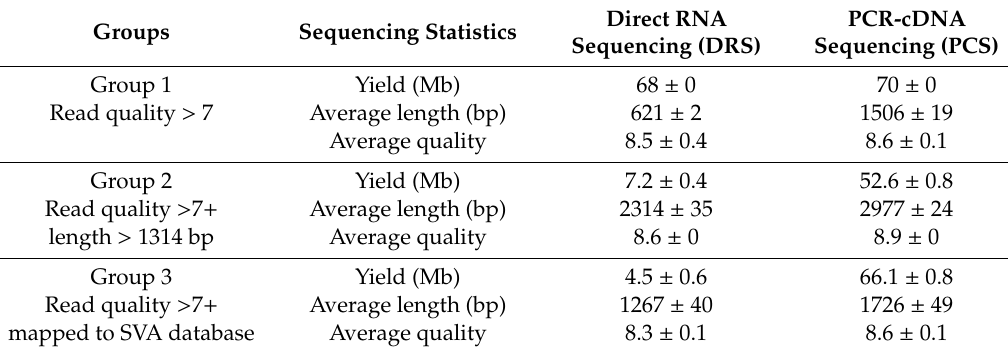
Table 2. Sequencing raw read statistics after using di ff erent read filters